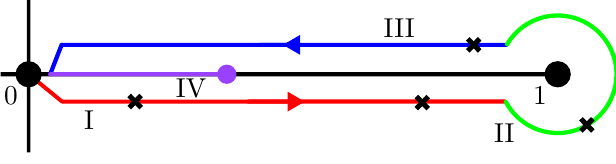
terms. { a i } . Due to the nesting, these x ’s are ordered. 0